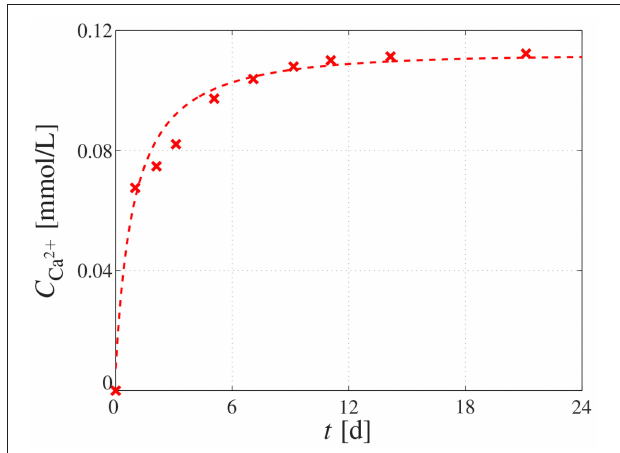
FIGURE 4 | Dissolution behavior of CHA granules. Calcium concentration measured in the buffer solution by means of atomic emission spectrometry, reflecting the dissolution behavior of the immersed CHA granule; the cross-shaped markers represent the measured data, whereas the dashed graph represents the fitting of the experimental data by means of function C (0.1073 t 2 5.18 t 0.3093) / ( t 2 44.11 t Ca 2 + = + + + +